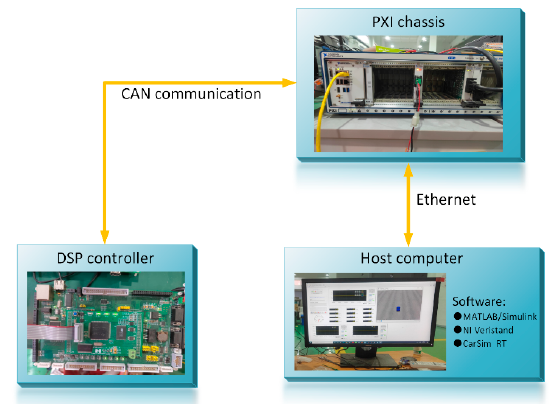
Figure 15. Hardware-in-the-loop test platform.